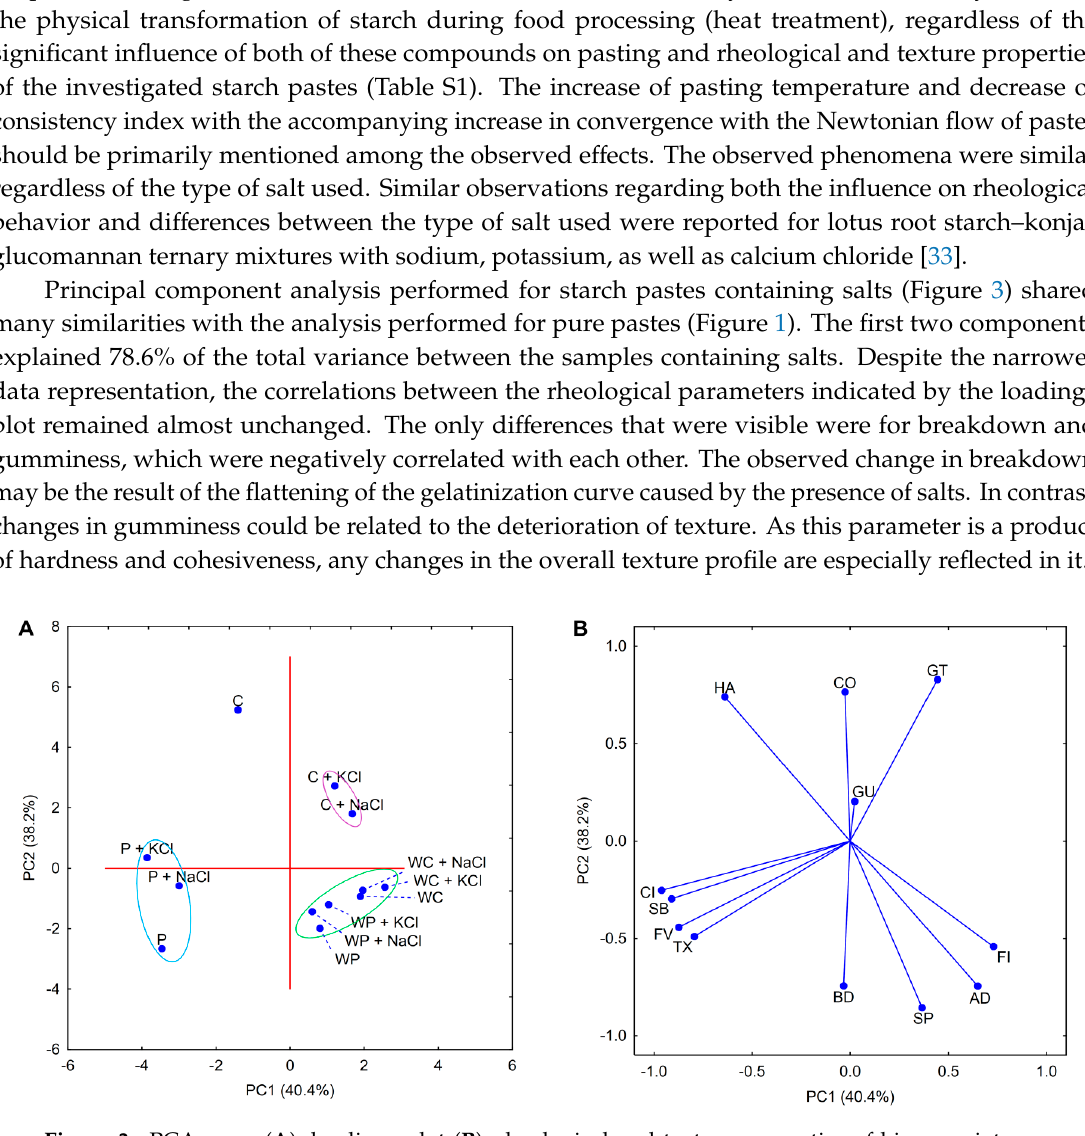
Figure 3. PCA score ( A ); loadings plot ( B ); rheological and texture properties of binary mixtures of 5% native starch pastes with 3%